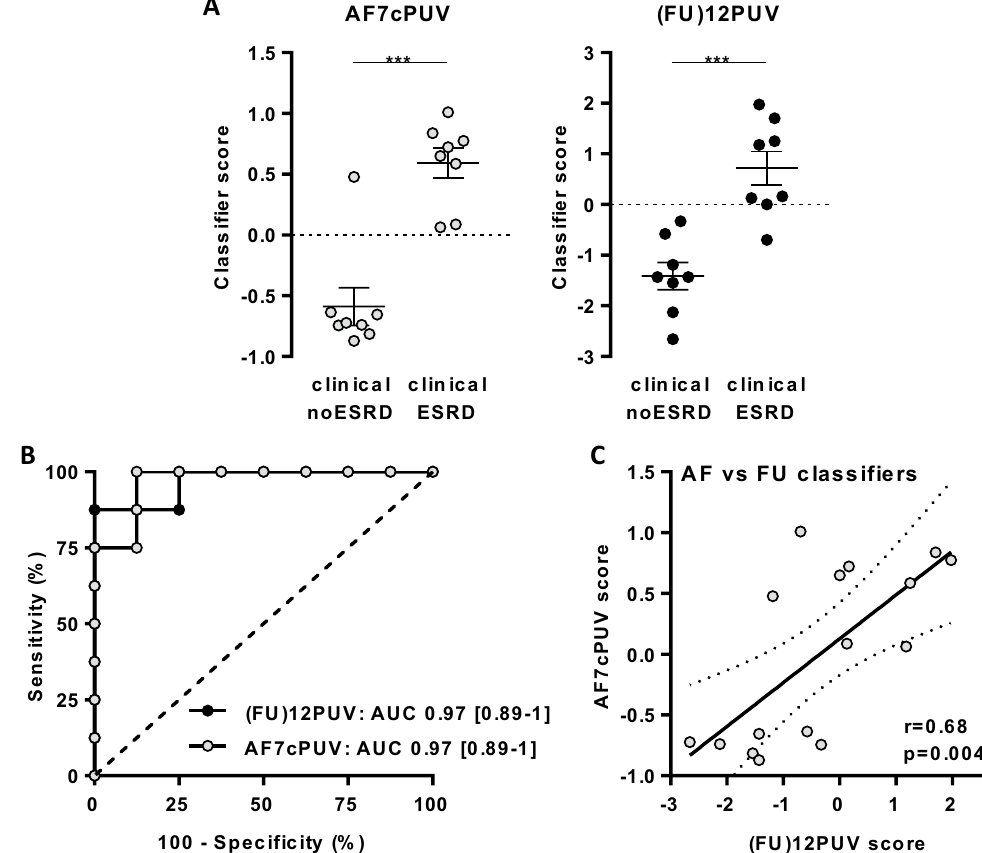
Figure 4. Potential of amniotic peptides for the prediction of renal survival in PUV fetuses. ( A ) Scatter dot plots showing AF7cPUV and (FU)12PUV classifier-based scores in 16 PUV patients from the validation cohort. The dotted horizontal line indicates the cutoff score (0 for both AF7cPUV and (FU)12PUV). A score > cutoff suggested early development of ESRD whereas a score < cutoff predicted fetus in the noESRD group. Data are means ± SEM. ***p < 0.001 versus noESRD according to Mann–Whitney test. ( B ) Compared ROC curves of AF7cPUV and (FU)12PUV. Brackets indicated confidence intervals for AUC. ( C ) Correlation between AF7cPUV and (FU)12PUV based